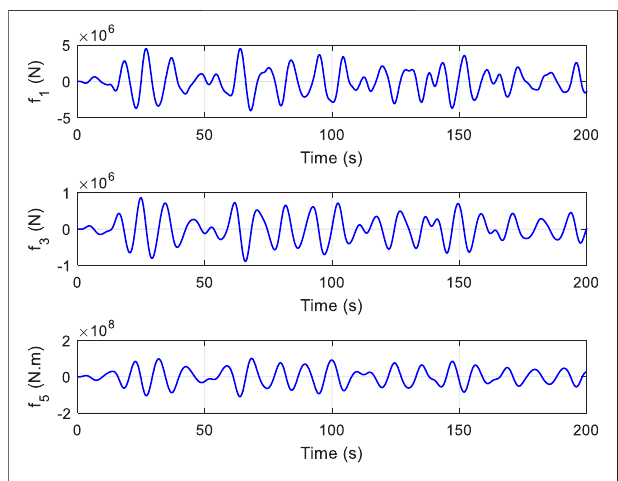
FIGURE9| Wave force induced byincident waves. (A) f1(t); (B) f3(t) and (C)